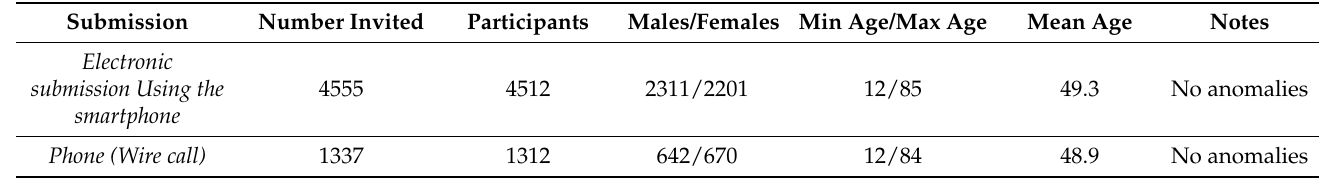
Table 1. Characteristics of the participants in the two submissions, electronic based on smartphone ( ES ) and telephonic (phone submission ( PS )) based on a wire call.